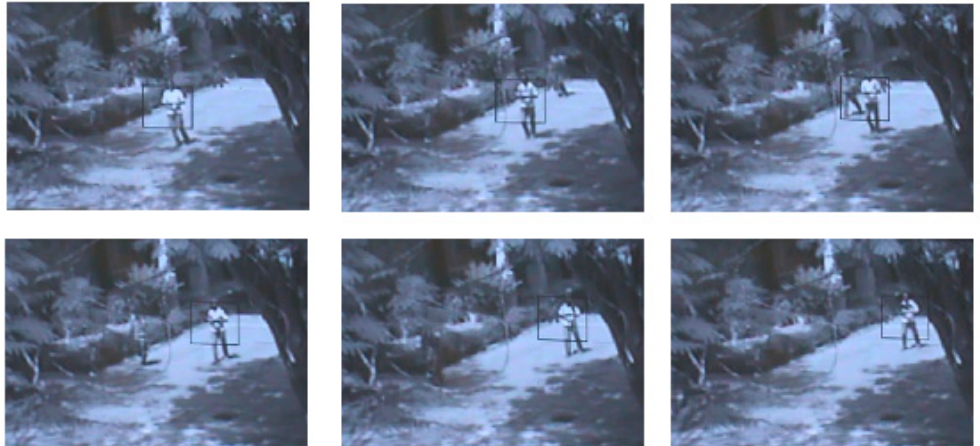
Figure 18. Frame sequence showing object tracking in outdoor scenes. J. Imaging 2017 , 3 , 18